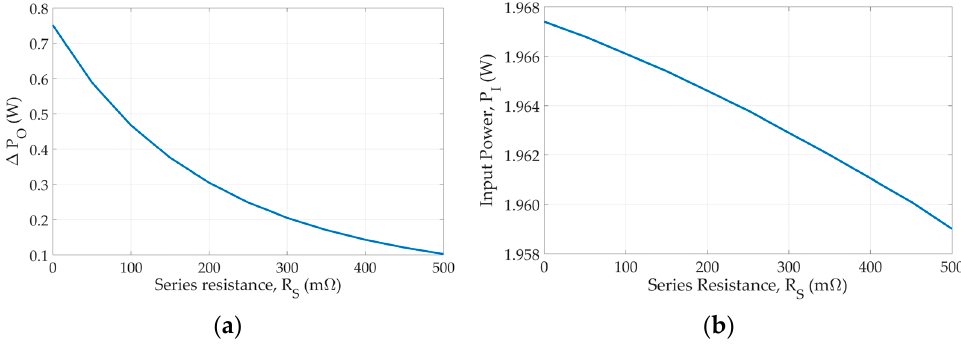
Figure 10. Variation in ( a ) output power and ( b ) input power with respect to series resistance.